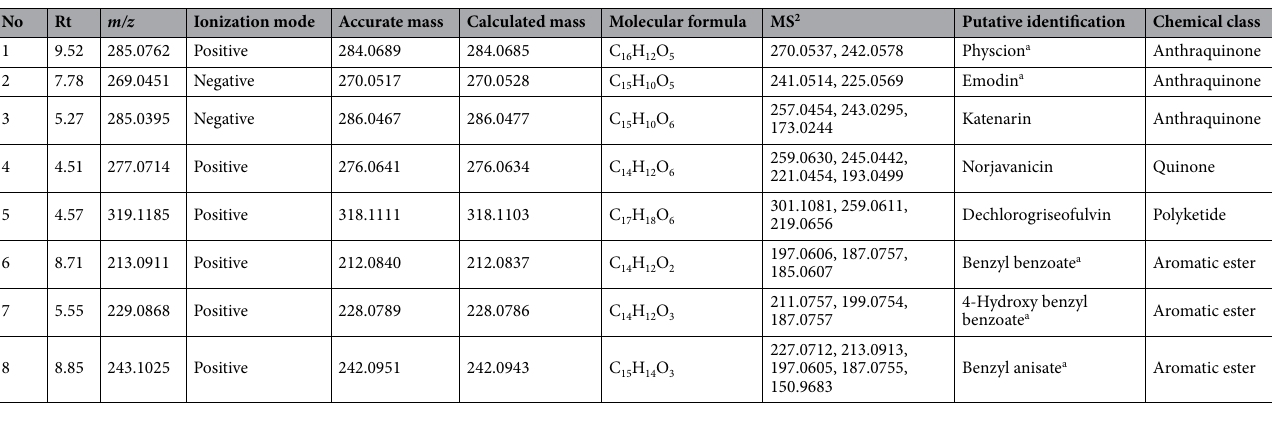
Table 2. Metabolites correlated to the anti-plasmodial activity of the tested endophyte-derived extracts. a Its identity was further confirmed by comparison with authentic standards.